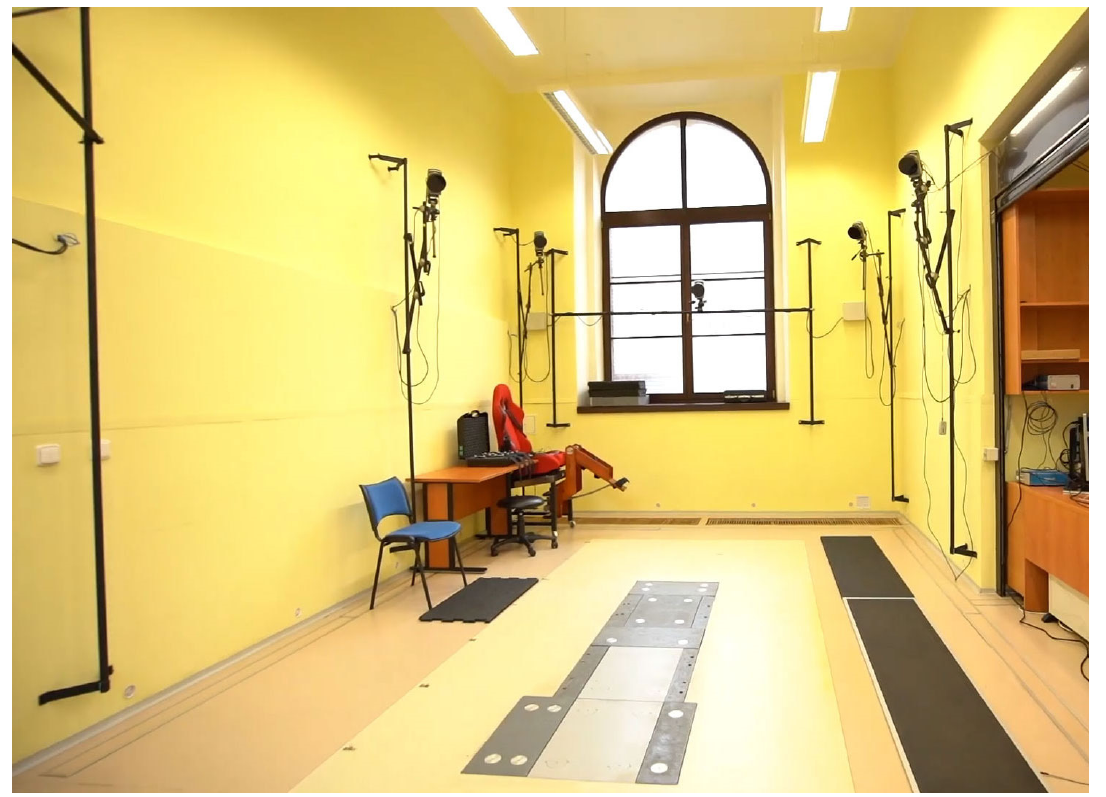
Figure 1. The specialized laboratory with 5 of the 11 infrared cameras Oqus 300 and 300+ visible, placed along the laboratory walls and 2 force platforms (light grey rectangles) placed on the laboratory floor.